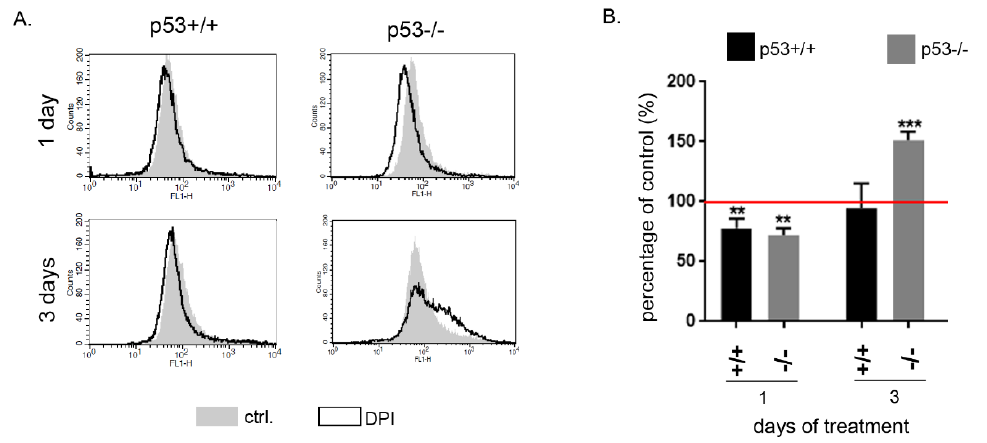
Figure 4. DPI decreases ROS level in HCT116 p53 proficient and p53 deficient cells. Cells were treated with 0.5 µ M DPI and after 1 or 3 days the level of ROS was estimated using the H 2 DCFDA probe. ( A ) Representative histograms and relative ROS level in DPI treated cells are presented ( B ) Mean ROS level ±SD from 4 independent experiments; ** p ≤ 0.01; *** p ≤ 0.001.